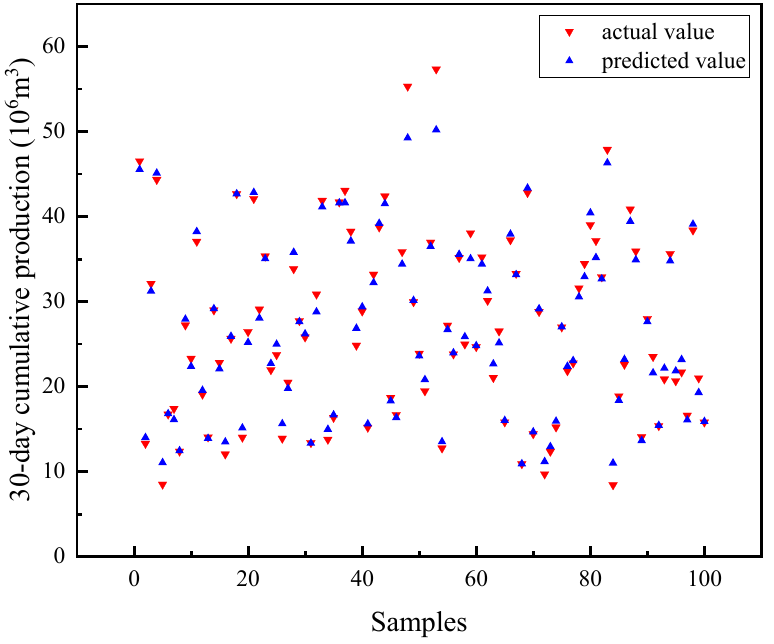
Figure 4. Comparison plots of actual values vs. predicted values for the testing samples. The blue triangles denote the predicted values, and the red inverted triangles represent the actual values.